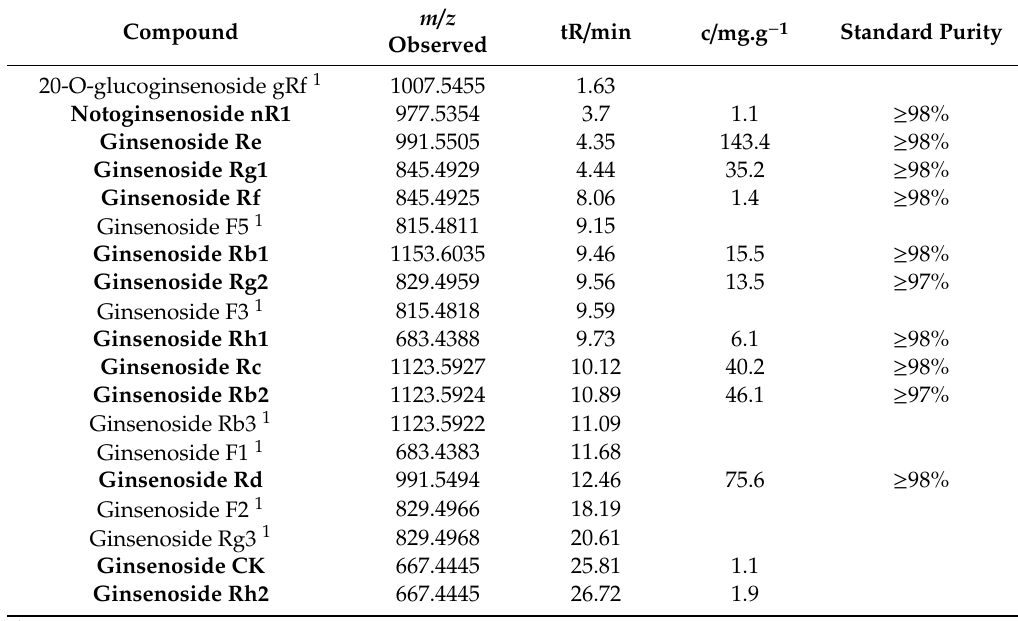
Figure 7. HPLC-MS analysis of 80% ginseng extract. A total ion current (TIC) chromatogram is shown, indicating seven ginsenosides (denoted in black) without and twelve ginsenosides (denoted in blue) with quantitation. Table 2. Identification and quantitation of